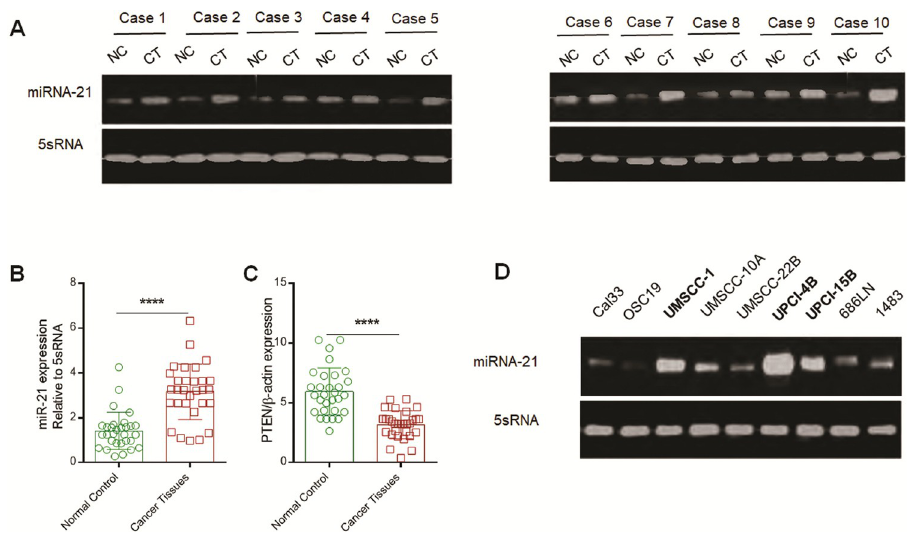
squamous cell cancer, case-4, -5, and -7 and -8 were laryngeal squamous cell cancer, and case-9 and -10 were hypopharyngeal squamous cell cancer. (B) and (C) Comparison of miR-21 and PTEN expression between cancer tissues and the corresponding matched adjacent NC tissues, respectively. P < 0.0001. (D) Among 8 head and neck SCC cell lines, miR-21 was significantly overexpressed in UMSCC-1, UPCI-4B, and UPCI-15B cells. CT, cancer tissue; NC, normal control, referring to the adjacent normal tissue. ���� , P <